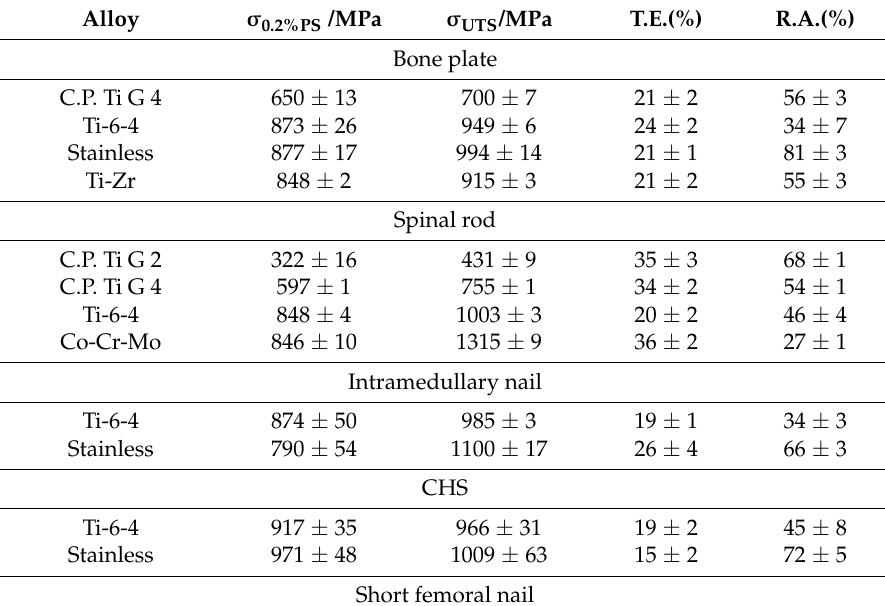
Table 1. Tensile properties of various osteosynthesis devices.